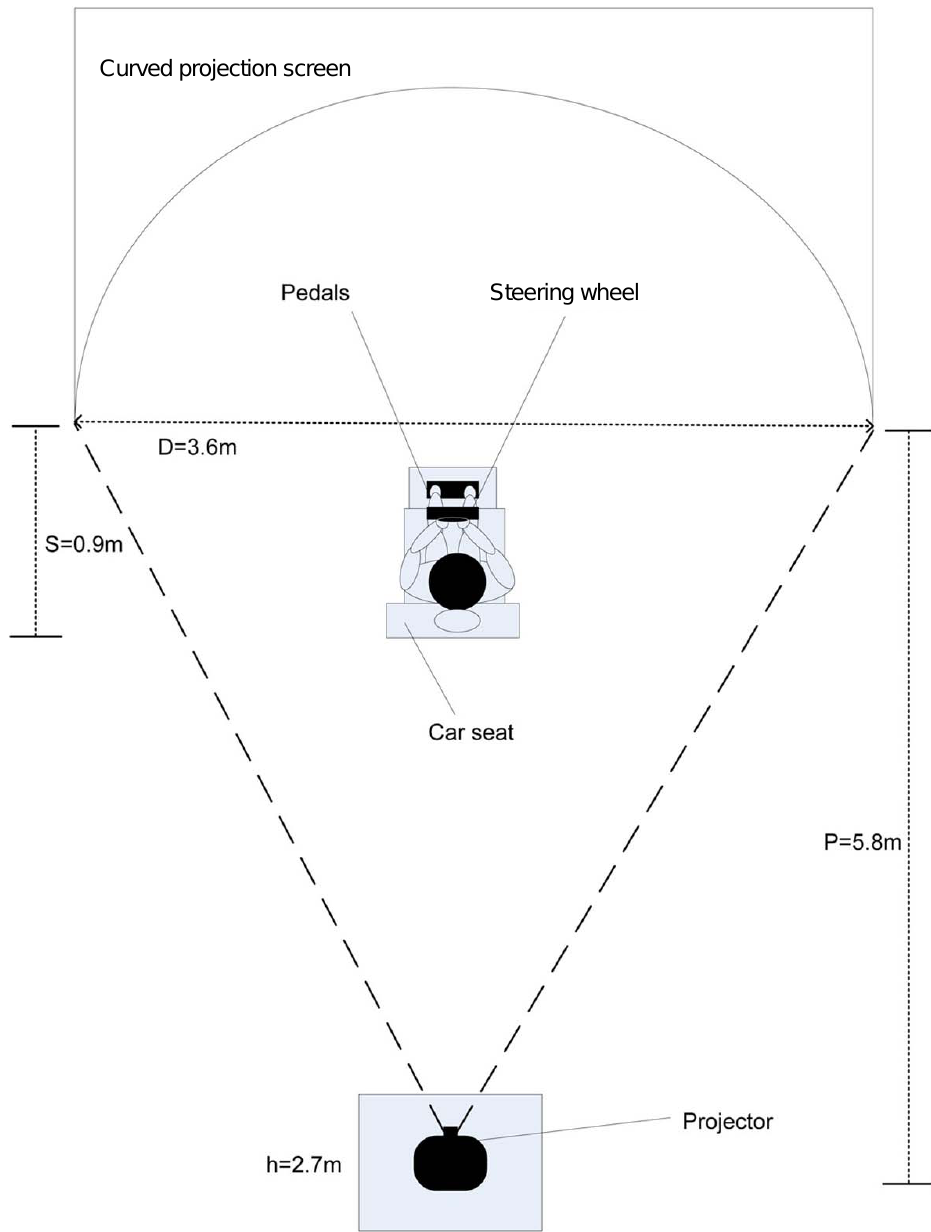
Figure 9. Driving simulator